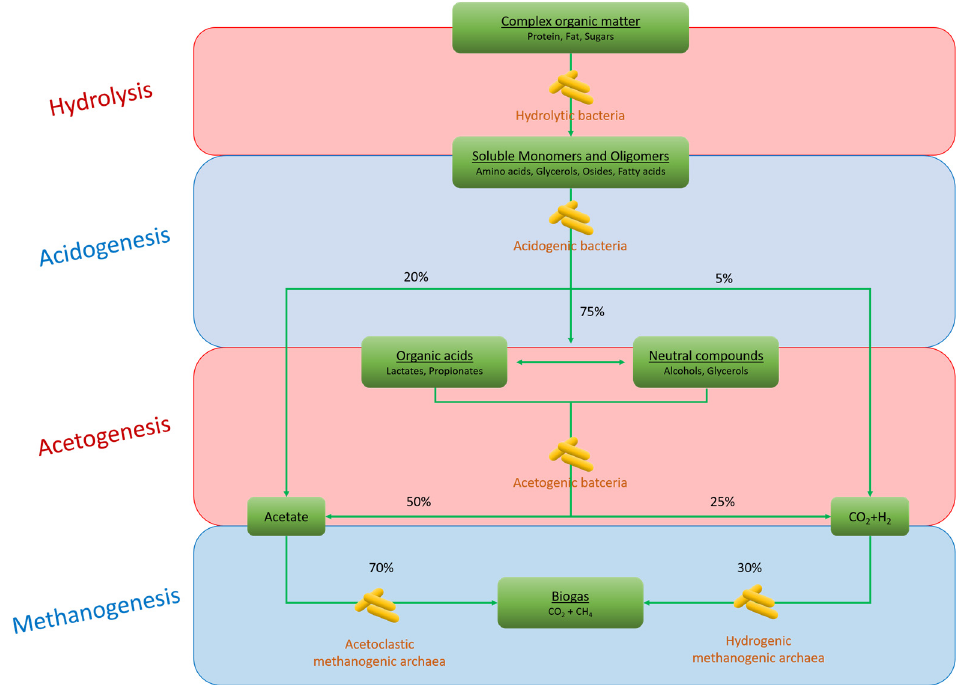
Figure 2. Four major steps of anaerobic digestion.